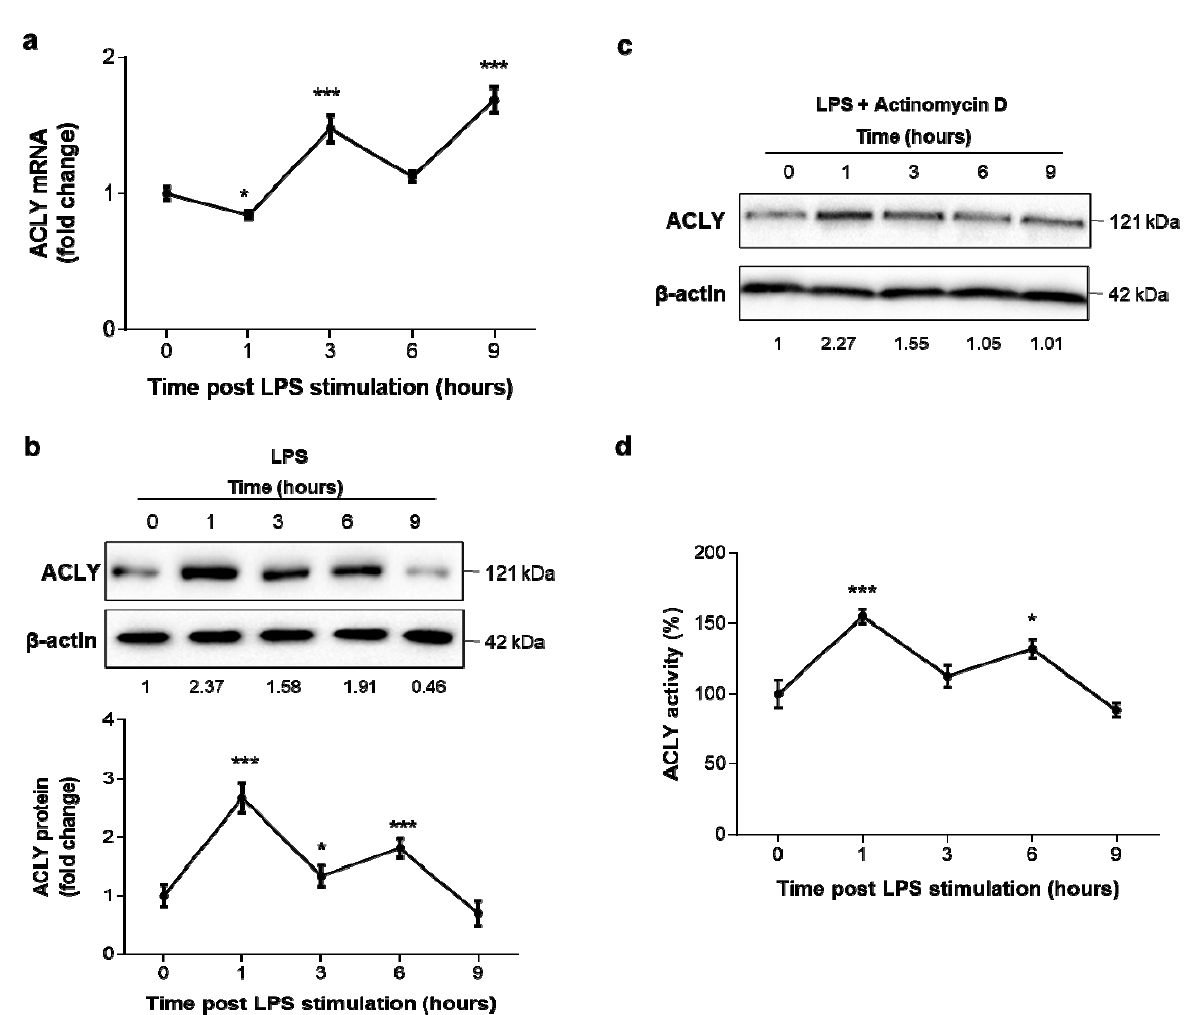
Figure 1. Early ACLY expression and activity in LPS-triggered human macrophages. Human PBMC-derived macrophages were triggered by LPS, and real time PCR and western blot analyses were performed to evaluate the ACLY mRNA ( a ) and protein ( b ) levels, respectively. The bottom panel in ( b ) shows ACLY protein quantitation across 6 independent western blots. ( c ) ACLY and β -actin proteins from human PBMC-derived macrophages, treated as described above but in the presence of actinomycin D, were detected by specific antibodies. ( d ) Time course of ACLY activity in human PBMC-derived macrophages. In ( a , d ), data are representative of 3 independent experiments and are presented as means ± SD (error bars). Where indicated in ( a , d ), differences were significant according to one-way ANOVA followed by Dunnett’s multiple comparison test (* p < 0.05; and *** p < 0.001). The mean values of treated cells were normalized to the mean values of untreated cells. Western blotting data presented are representative of at least 3 independent experiments. Protein levels quantified against β -actin and normalized versus untreated cells (0) are reported under western blotting images.